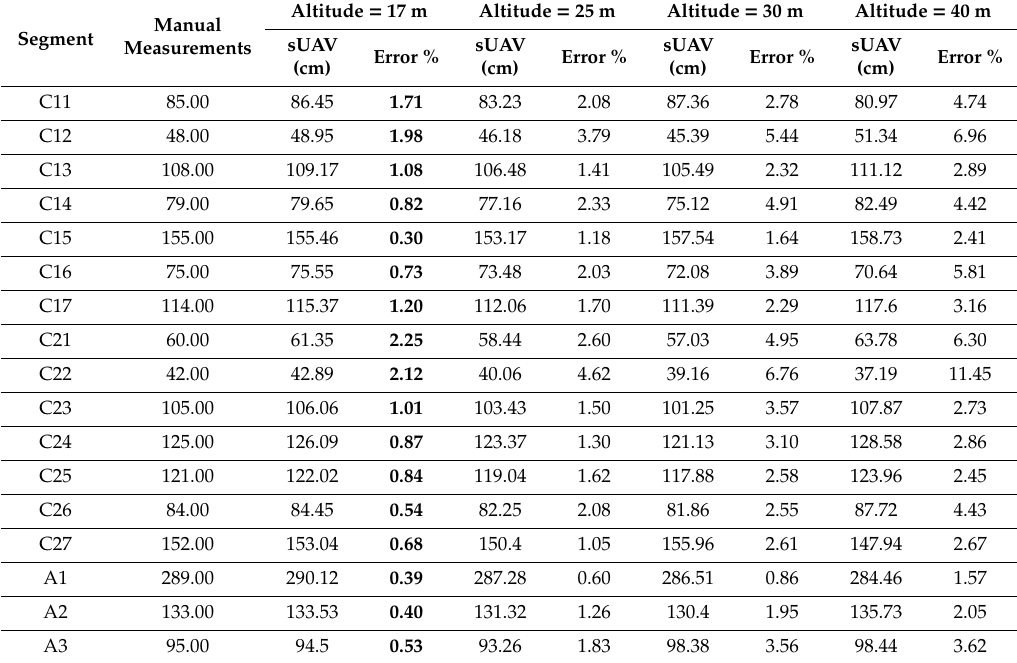
Table 4. Manual measurements vs. sUAV measurements of the accident scene at various flight altitudes.